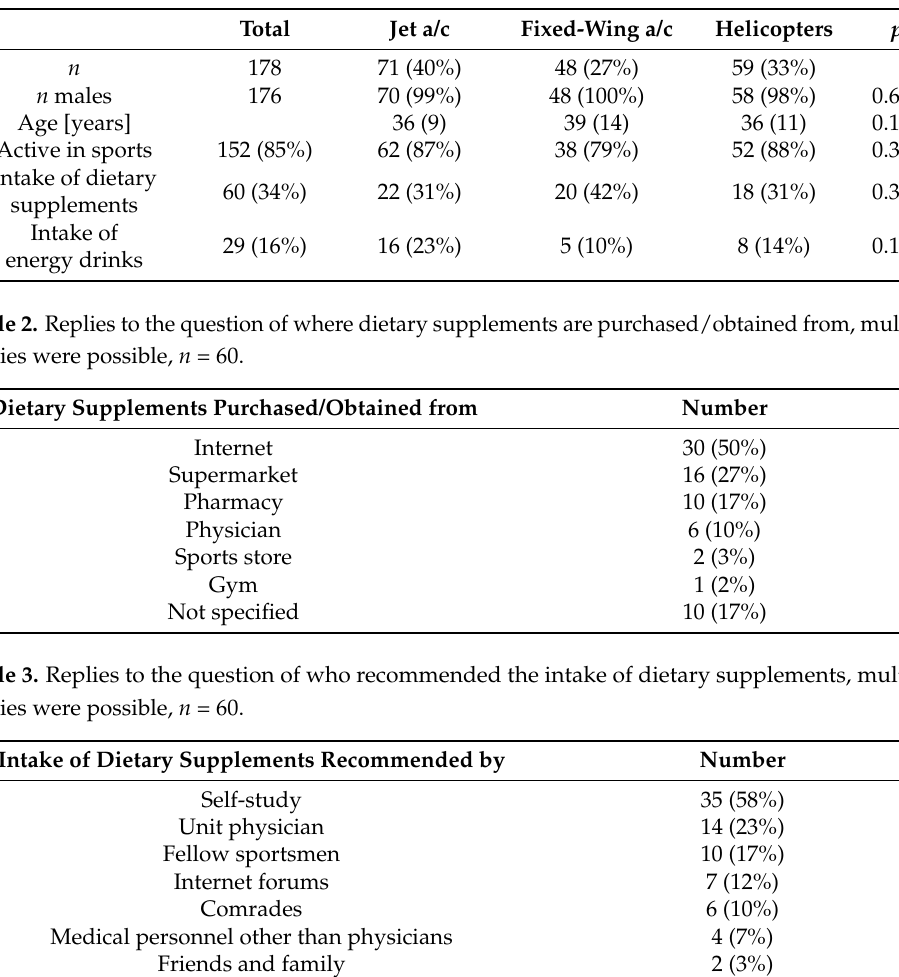
Table 1. Number of participants for the entire group and for the three types of aircraft (a/c) with median (interquartile-range) for age and number of males, sports activities, prevalence of the intake of dietary supplements and energy drinks.